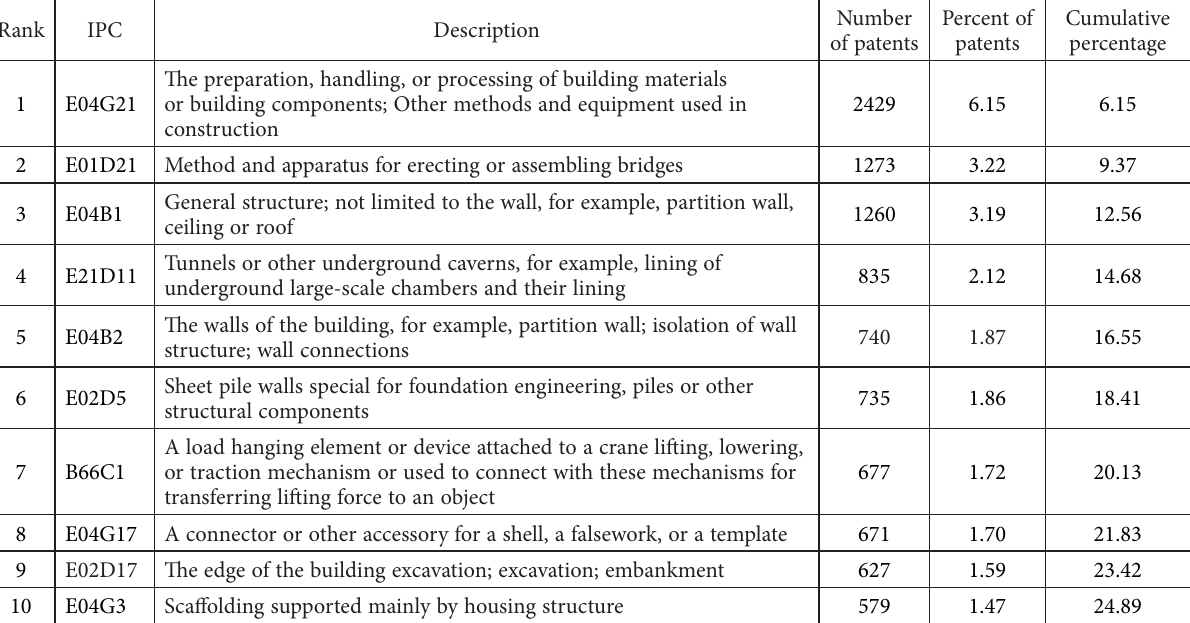
Table 2. Top 10 technology fields in Chinese construction